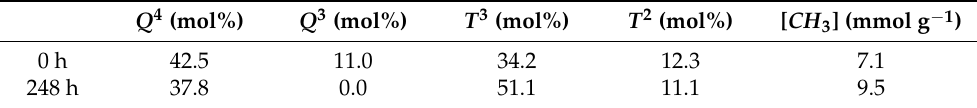
Table 2. Deconvolution results of solid state 29 Si MAS NMR spectra of the unsupported MSL exposure to MTBE aqueous solution for different